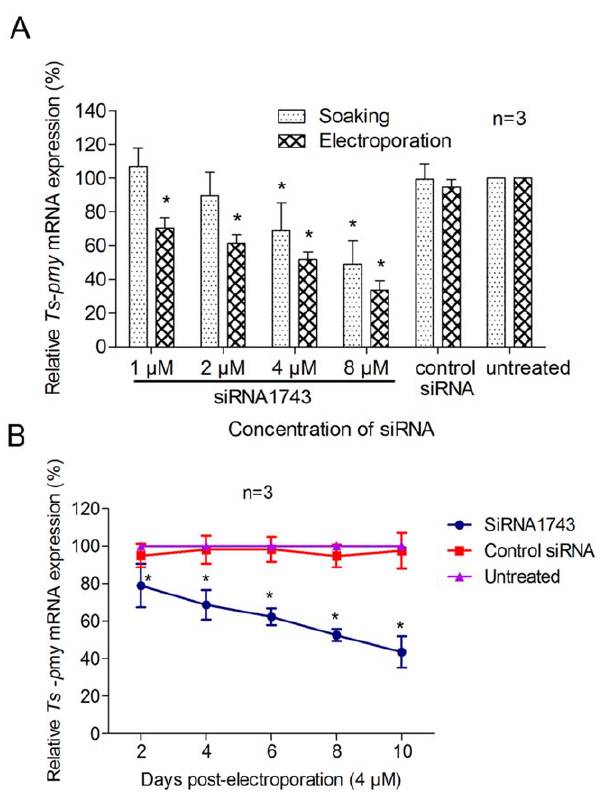
Figure 2. The silencing of Ts-pmy mRNA in larvae treated with siRNA1743. The relative level of Ts-pmy mRNA in larvae following electroporation or soaking with various concentrations of siRNA1743 for 6 days, as determined with qRT-PCR (A). The better siRNA suppressive effect in treated larvae was observed when a longer incubation was applied after electroporation (B). All of the assays were performed in triplicate, and the data are presented as the mean 6 SE. * p , 0.05 compared with control siRNA.